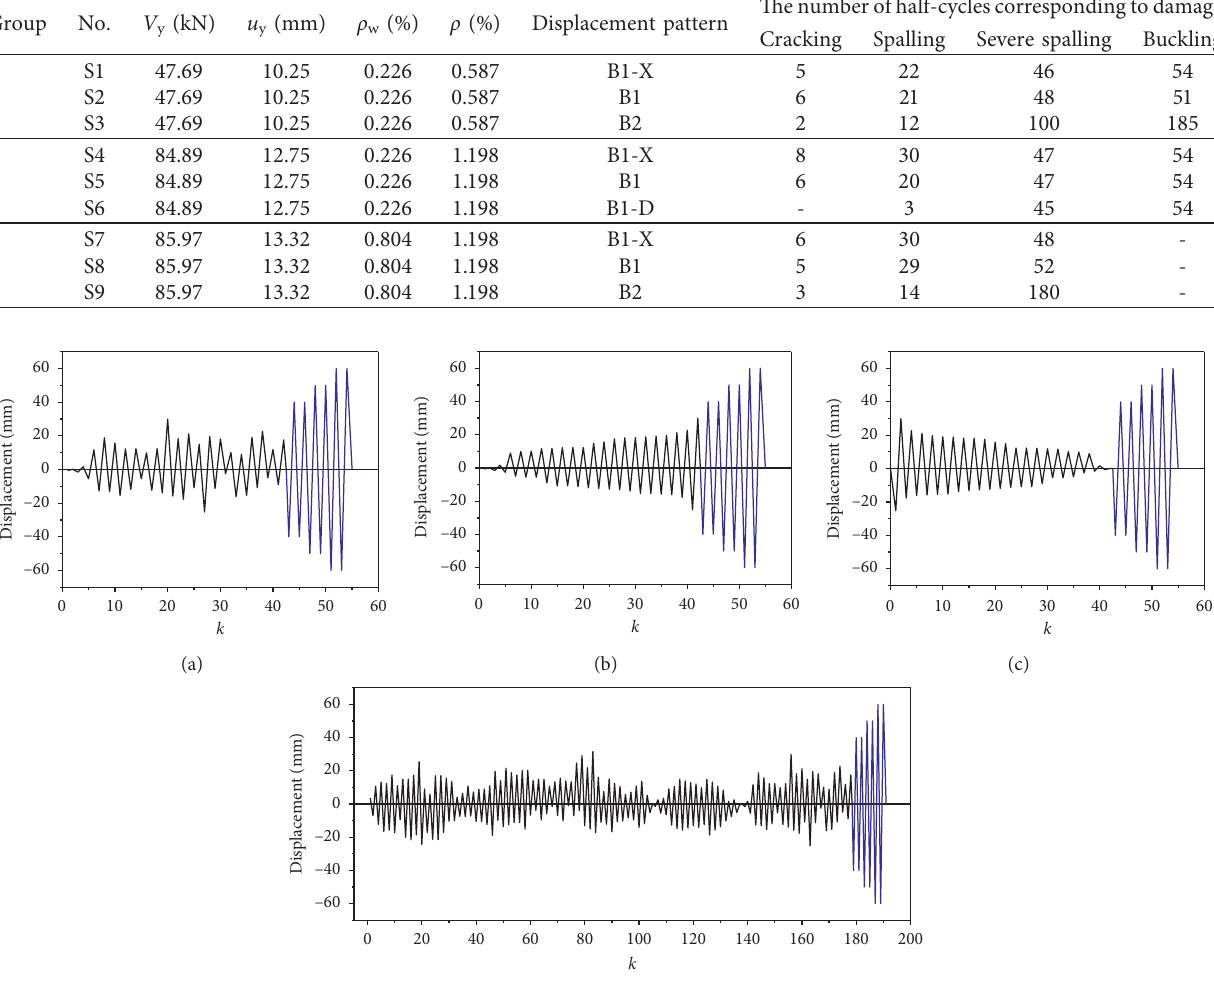
Table 4: The properties and the number of half-cycles corresponding to the damage for specimens S1 to S9 [22]. Group